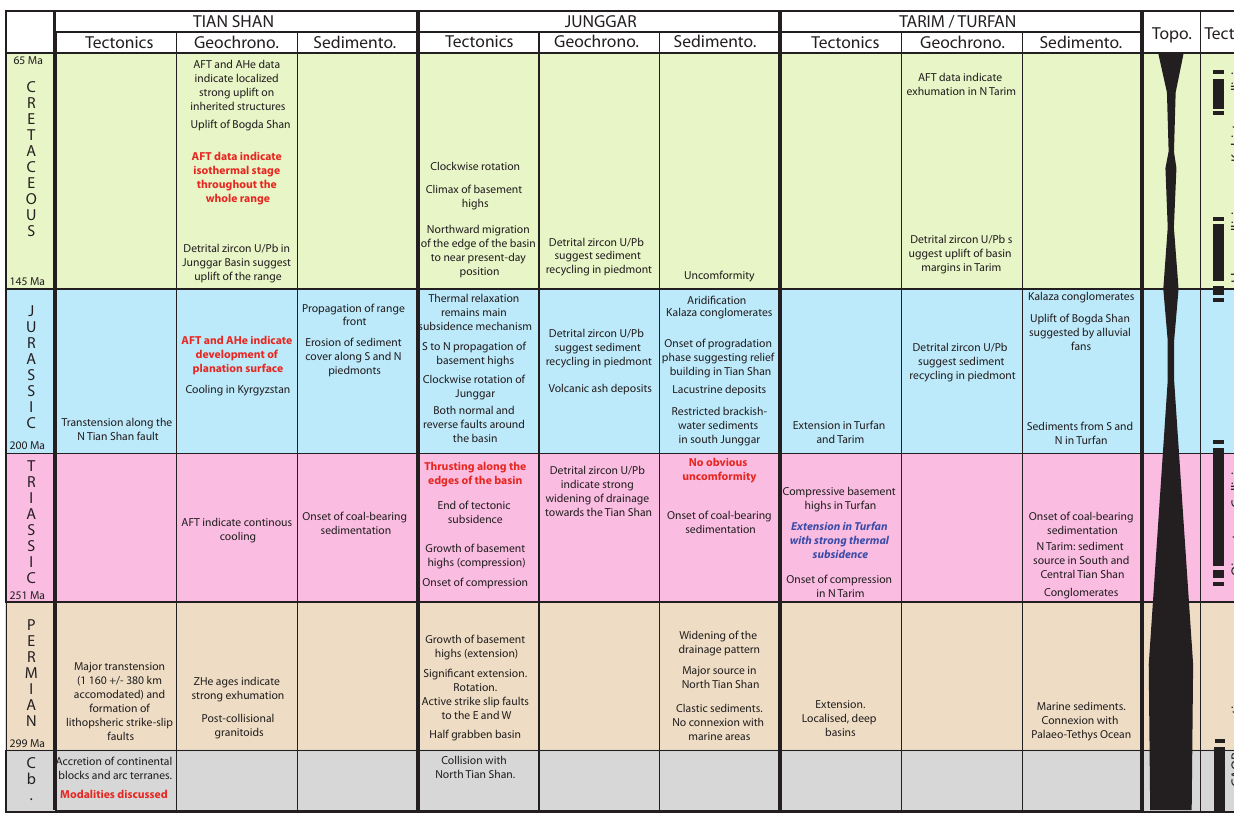
Fig. 2. Summary of the main Mesozoic tectonic, geochronological and sedimentological constrains in the Tian Shan Range and the Junggar and Tarim-Turfan basins. The data indicated in red are apparently in contradiction with the interpretation derived from other available data at the same time. The data in blue is contradicting the others but can be explained by local mechanisms. Column Topo. indicates the relative increase (wide black line) or decrease (thin black line) of the Tian Shan general topography. Column Tecto. recalls the major geodynamic events that affected Central